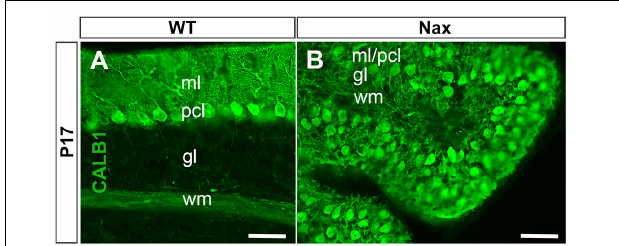
FIGURE 1 | Sagittal sections at P17 of the wt and nax cerebellum. (A) Immunostaining with anti-calbindin (CALB1) in a section through the cerebellum of the wt sibling showing the dendrites of PCs in the molecular layer (ml) and Purkinje cell (PC) soma in the Purkinje cell layer (PCl). (B) In the nax cerebellum showing that the PCs fail to form a uniform monolayer and PCs soma are intermingled in the ml; labeled as pcl/ml. gl, Granular layer; wm, white matter. Scale bar: A = 50 µ m; B = 50 µ m.